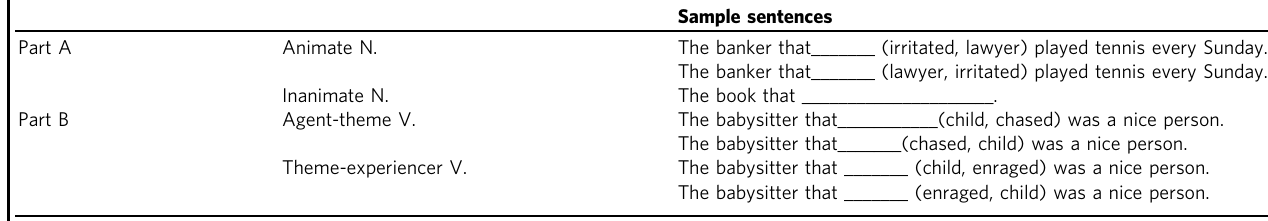
Sample sentences